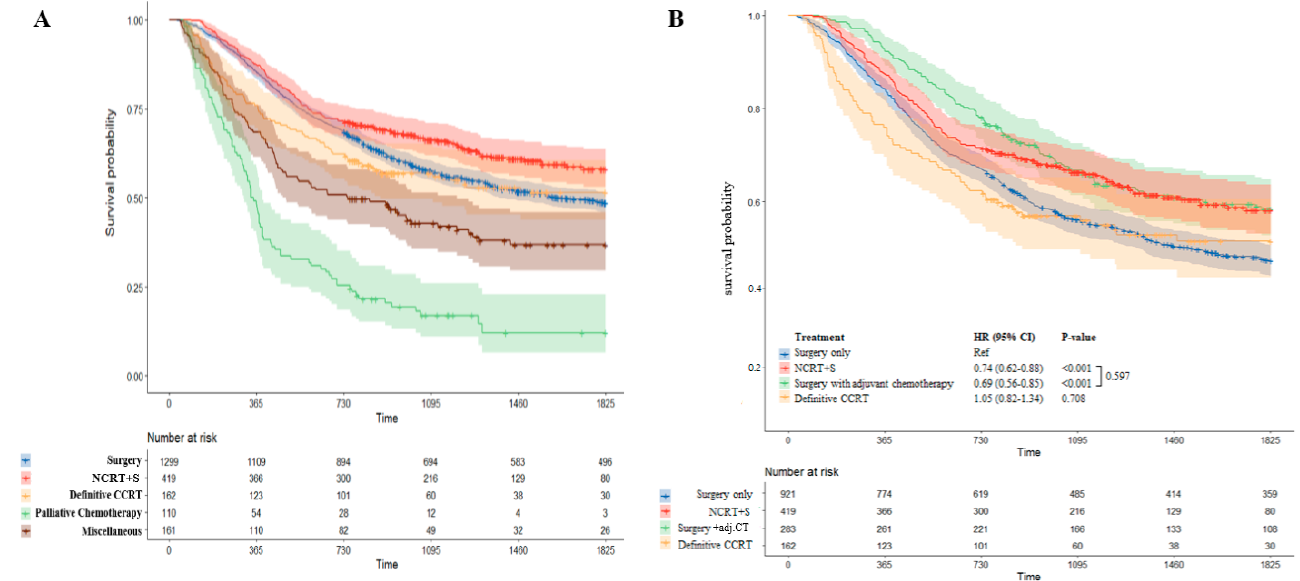
Figure 5. Comparison of Kaplan–Meier survival curve by treatment modality. Survival outcomes according to the type of initial treatment are shown in ( A ). Surgery group was divided into patients with adjuvant chemotherapy and without adjuvant chemotherapy. A comparison of survival curves between these subgroups is presented in ( B